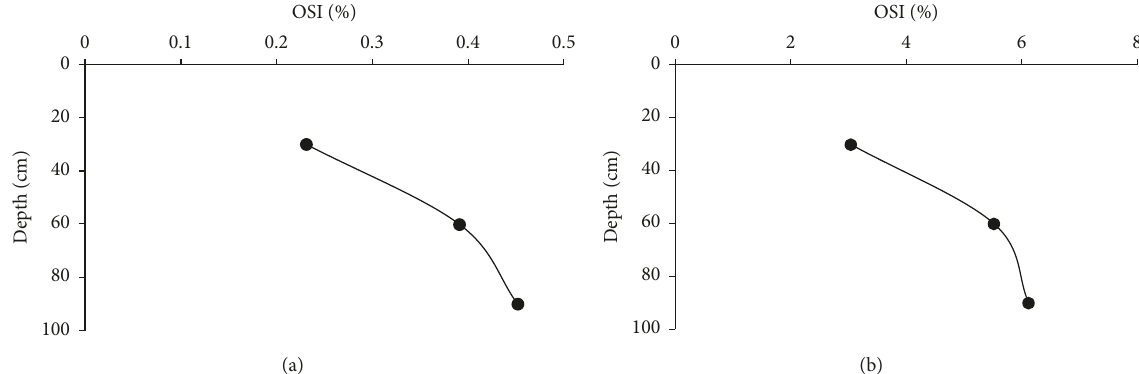
Figure 12: Oedometric swell index at different depths: (a) 50kPa loaded oedometric swell tests; (b) free oedometric swell tests.